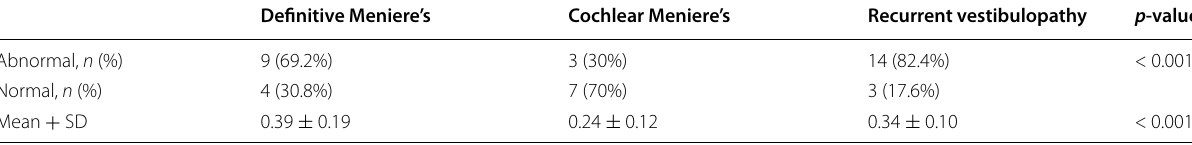
Table 10 Cervical vestibular evoked myogenic potentials normal and abnormal cases